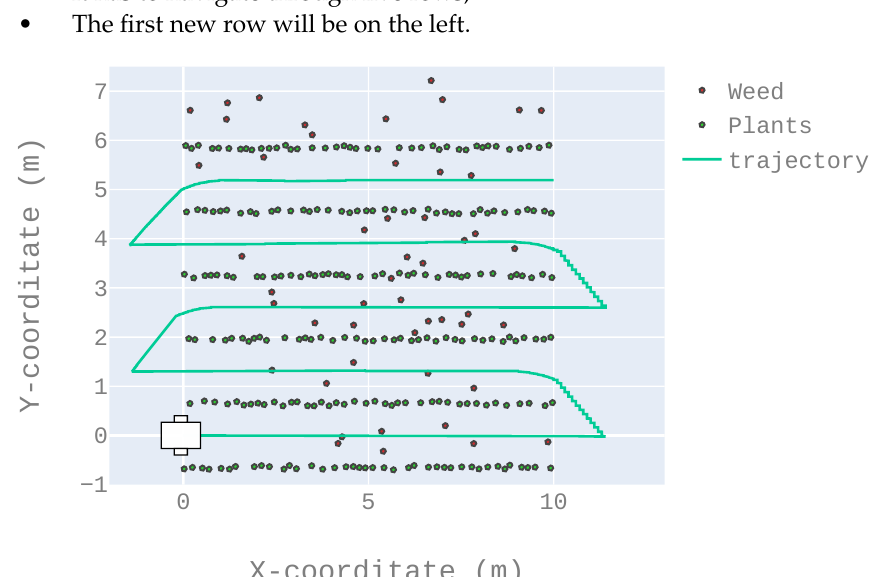
Figure 15. Example of trajectory: the robot starts at the position (0, 0), parallel to the crops, as depicted in the figure. Then it has to reach the end of the fifth row without running over the plants. This figure depicts an example of a successful